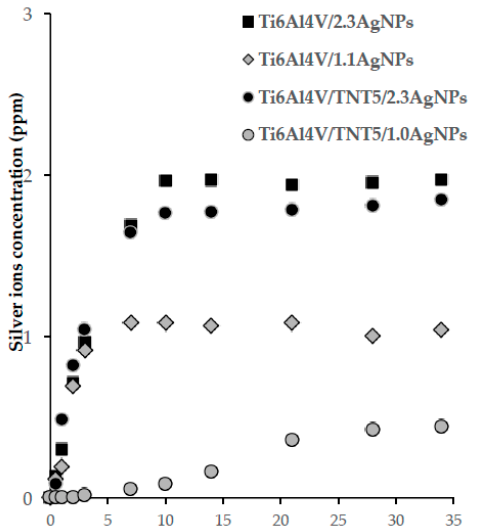
Figure 7. The release amount of Ag + ions from Ti6Al4V/AgNPs and Ti6Al4V/TNT5/AgNPs samples (containing 2.3 and 1.0–1.1 wt% of AgNPs) immersed in a phosphate buffered saline (PBS) and measured by inductively coupled plasma ionization mass spectrometry (ICP-MS).